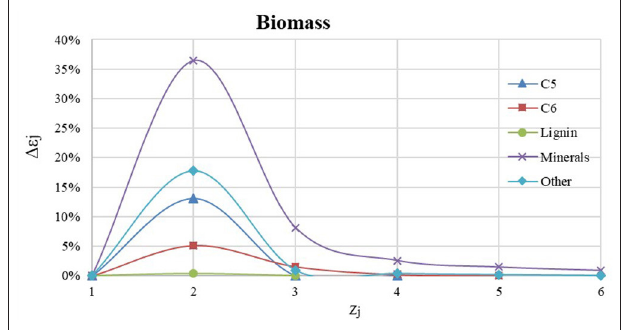
FIGURE 3 | Accuracy error vs. number of selected components.